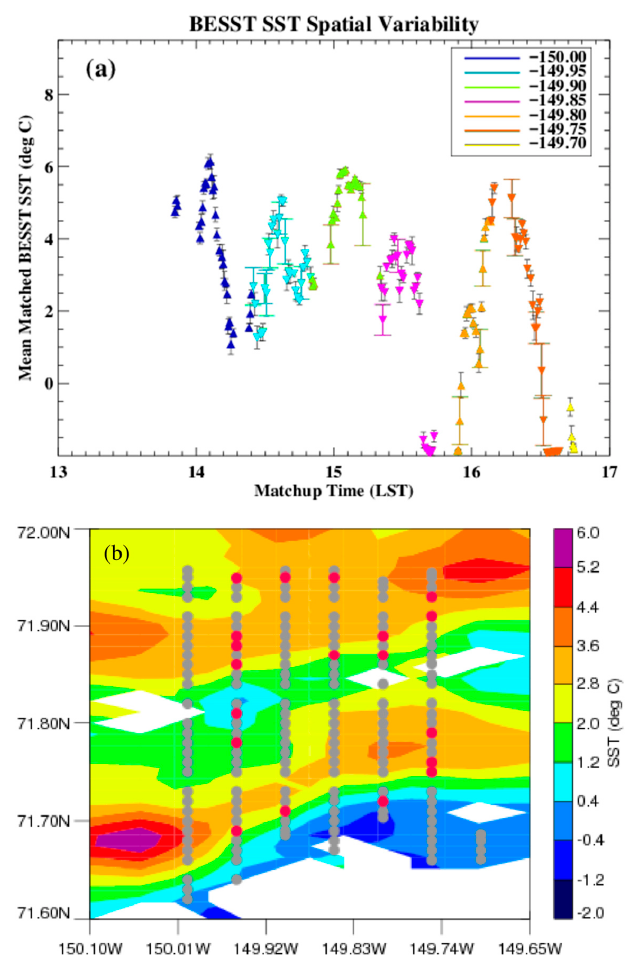
Figure 5. Time series ( a ) of time-lagged BESST SSTs matched to MODIS. The triangles represent the mean BESST temperature within the MODIS pixel. The color and vertex of the triangle indicates the flight transect and direction, respectively. Error bars correspond to 1- σ variability. Where σ ≥ 0.4 °C, the error bar is color coded by transect. The SST map shown in ( b ) is a contour representation of the MODIS composite (Figure 2) around the BESST survey (grey circles). Red circles illustrate the location of the BESST area-averaged measurements with σ ≥ 0.4.